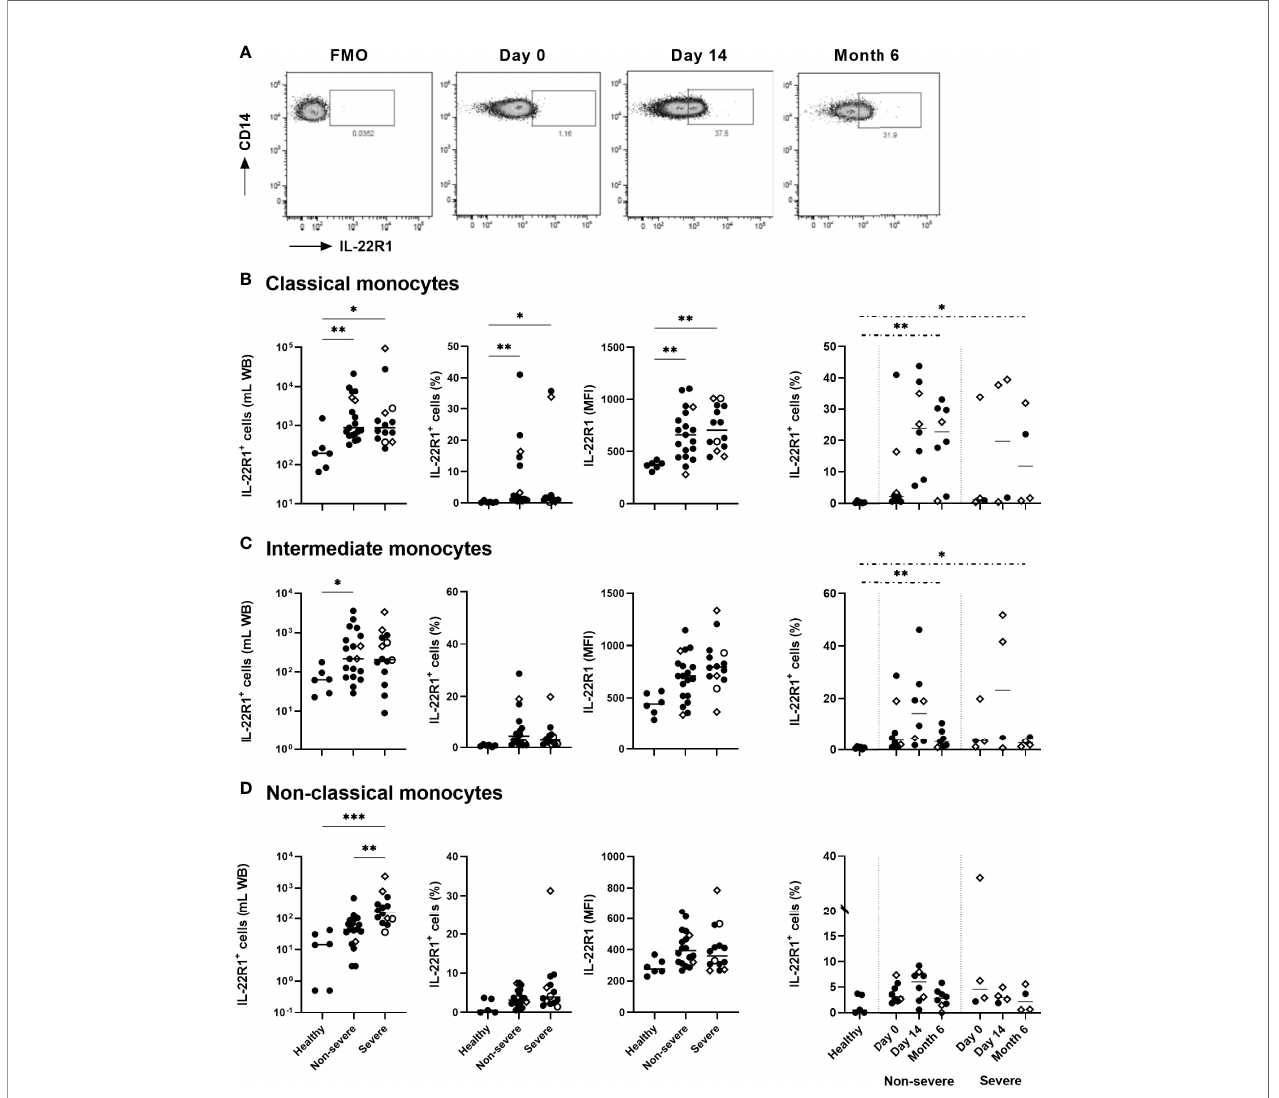
FIGURE 2 | IL-22R1 expression on human blood monocyte subsets in COVID-19 patients compared to healthy controls. (A) Representative pseudo-color plots of IL-22R1 + expression on classical monocytes from a severe COVID-19 patient, with a Fluorescence Minus One (FMO) control and the expressions at day 0, day 14 and six months later. The rectangular gate is used to identify the distinct upcoming population of myeloid cells expressing higher density of IL-22R1. The presentation of this distinct population became clearer at D14 and remained at least for 6 months. (B – D) Absolute cell numbers, percentages of the IL-22R1 + cells and median fl uorescence intensity of IL-22R1 on (B) classical, (C) intermediate and (D) non-classical monocytes are shown for healthy controls (n=6), non-severe (n=19) and severe (n=14) COVID-19 patients at day 0. Kinetic analysis of the percentages of IL22R1 + cells over time is represented for COVID-19 patients on the right panels at D0 and 14 days (11 non-severe, 9 severe) and six months (8 non-severe, 4 severe) later. The patients who died from COVID-19 are represented on the graphs as empty circles, and the patients who declared long-term COVID-19 at their 6 months follow-up (2 out of 8 non-severe and 3 out of 4 severe cases) are represented on the graphs as empty diamonds. The horizontal bars indicate the medians of the results within each column. The statistical analyses were performed by Kruskal Wallis test to compare results from the different groups of subjects at D0, and by Mann Whitney U test to compare patient ’ s results at Month 6 to controls. Signi fi cant differences are shown as * p <0.05, ** p <0.01, *** p <0.001. Time point comparisons at D0, D14 and Month 6 restricted to paired samples were performed by Friedman test and no signi fi cant differences were